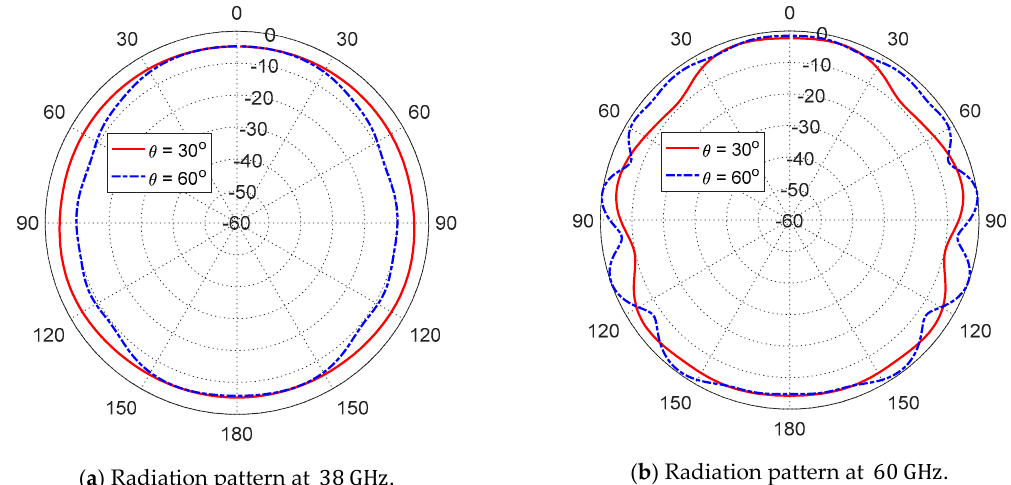
( a ) Radiation pattern at 38 GHz . ( b ) Radiation pattern at 60 GHz . Figure 12. Simulated radiation patterns in the azimuth planes for the dual-band microstrip patch antenna whose dimensions are shown in Figure 11.